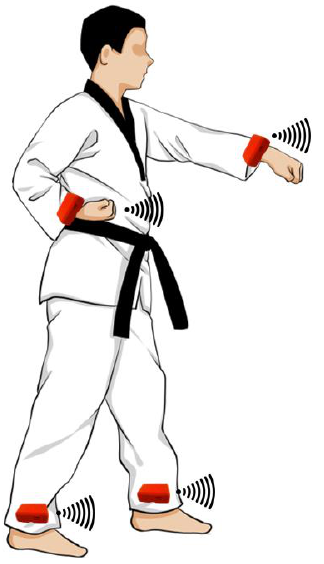
Figure 7. Positioning of motion sensors in the taekwondo athlete.